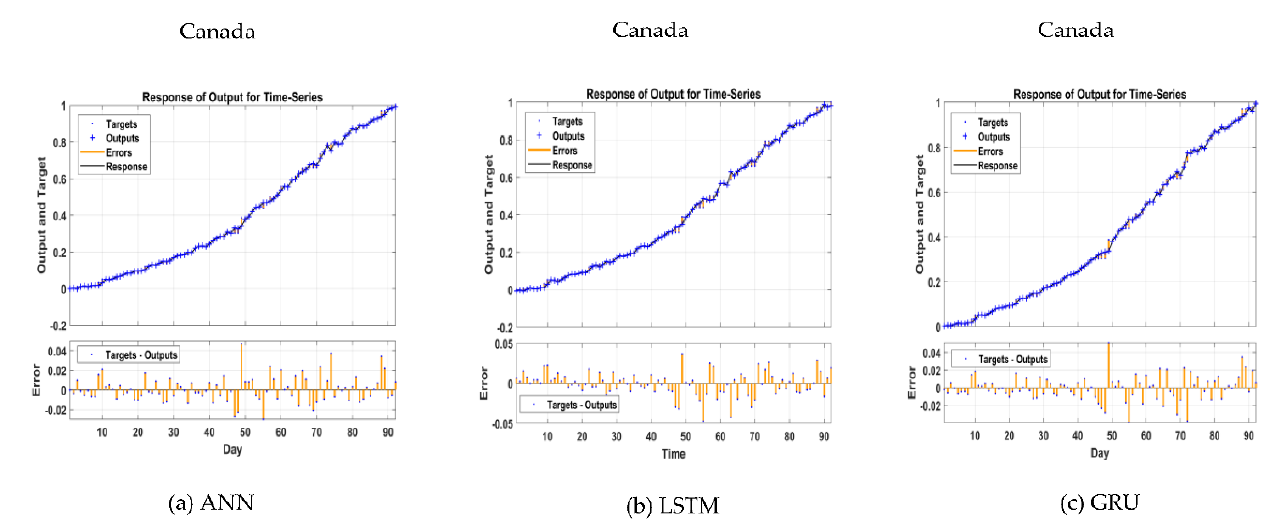
Figure 10. The responds plot of NN optimal model in predicting—Monkeypox.